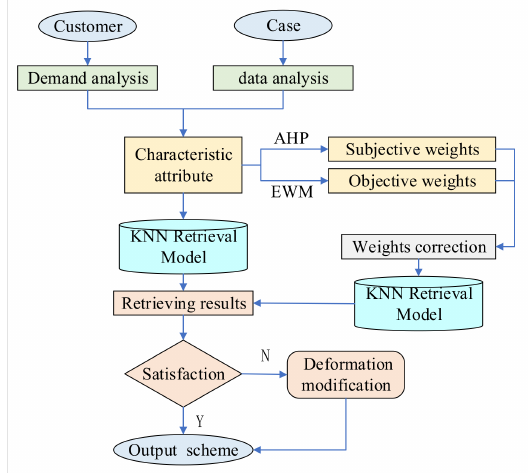
Figure 1. Chair pattern intelligent design